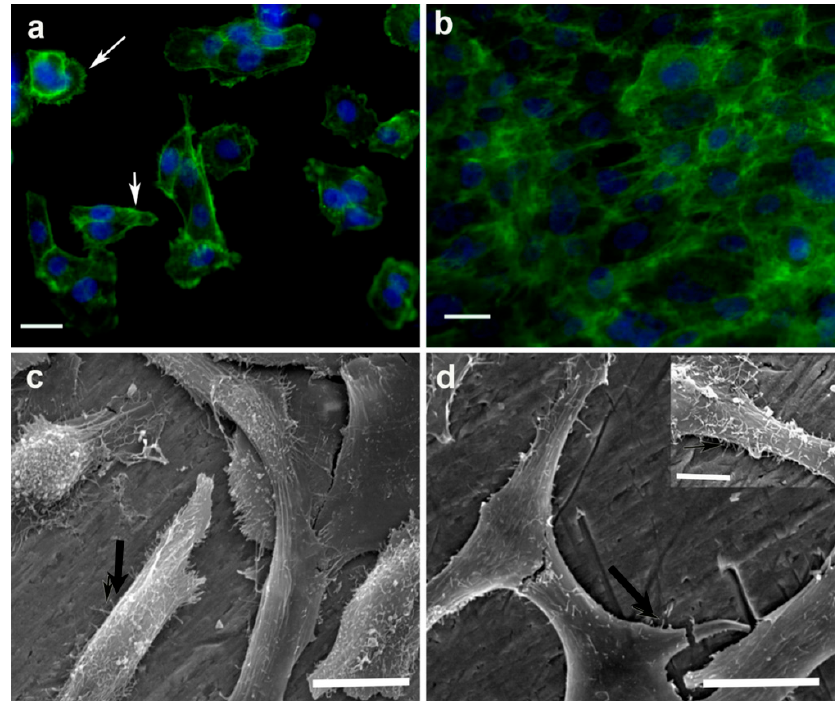
Figure 6. Fluorescence detection of F-actin stress fibres ( a , b ) and SEM micrographs ( c , d ) of MG63 cells cultured on ciprofloxacin-loaded PHEMA coatings on titanium at 24 h ( a , c ) and 120 h ( b , d ) of culture. Arrows in ( a ) indicate local contacts, in ( c , d ) filopodia and a star-shaped morphology. Main figure scale bar 20 µm; inset scale bar 5 µm. (Reprinted in part with permission from [100] 2011 Elsevier, copyright n. 4557620729304).